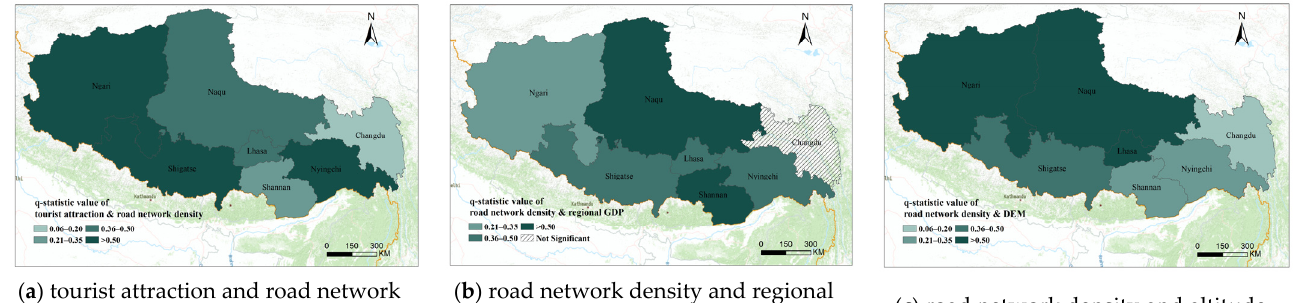
Figure 11. q -statistics of factor interactions by city in Tibet. Figure 11. q -Statistics of factor interactions by city in Tibet.